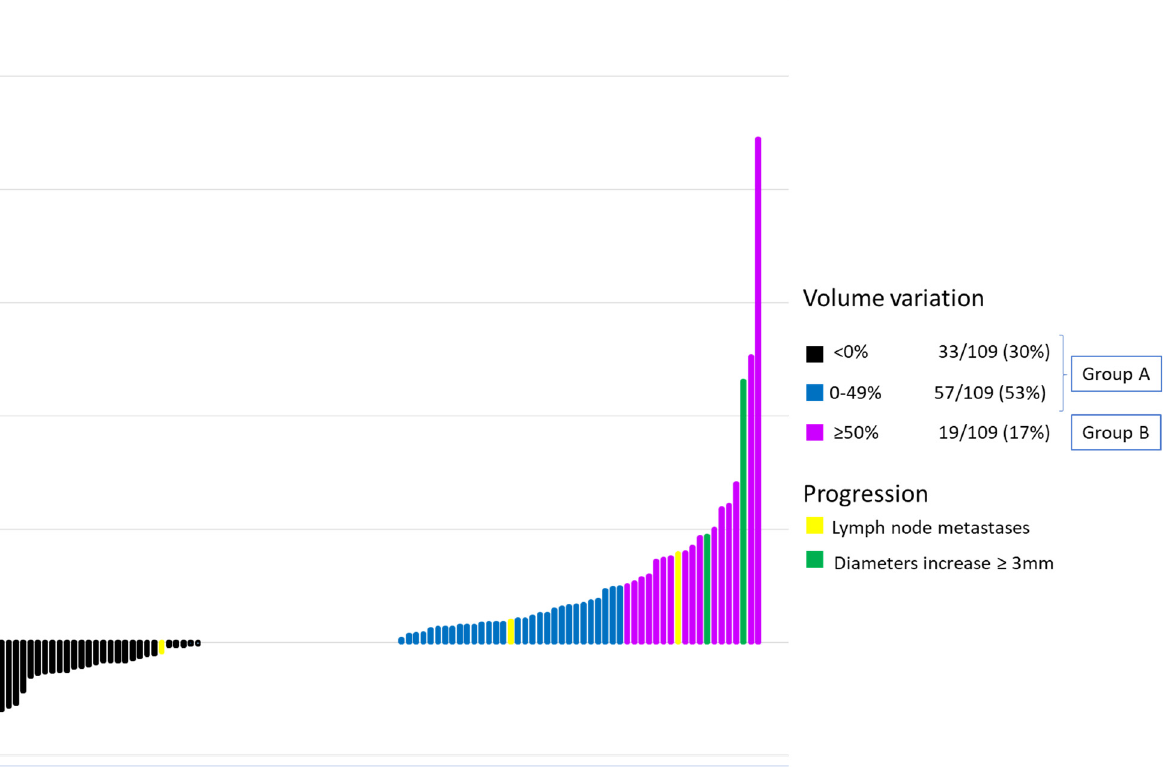
Figure 1. Each line expresses the extent of the volumetric variation of mPTC at the last check with respect to enrollment. Yellow and green lines represent the mPTC that have developed clinical progression during observation according to protocol criteria. Green lines identify the 2 mPTC that showed a ≥ 3 mm increase in each diameter. Yellow lines identify the 5 mPTC that have developed lymph node